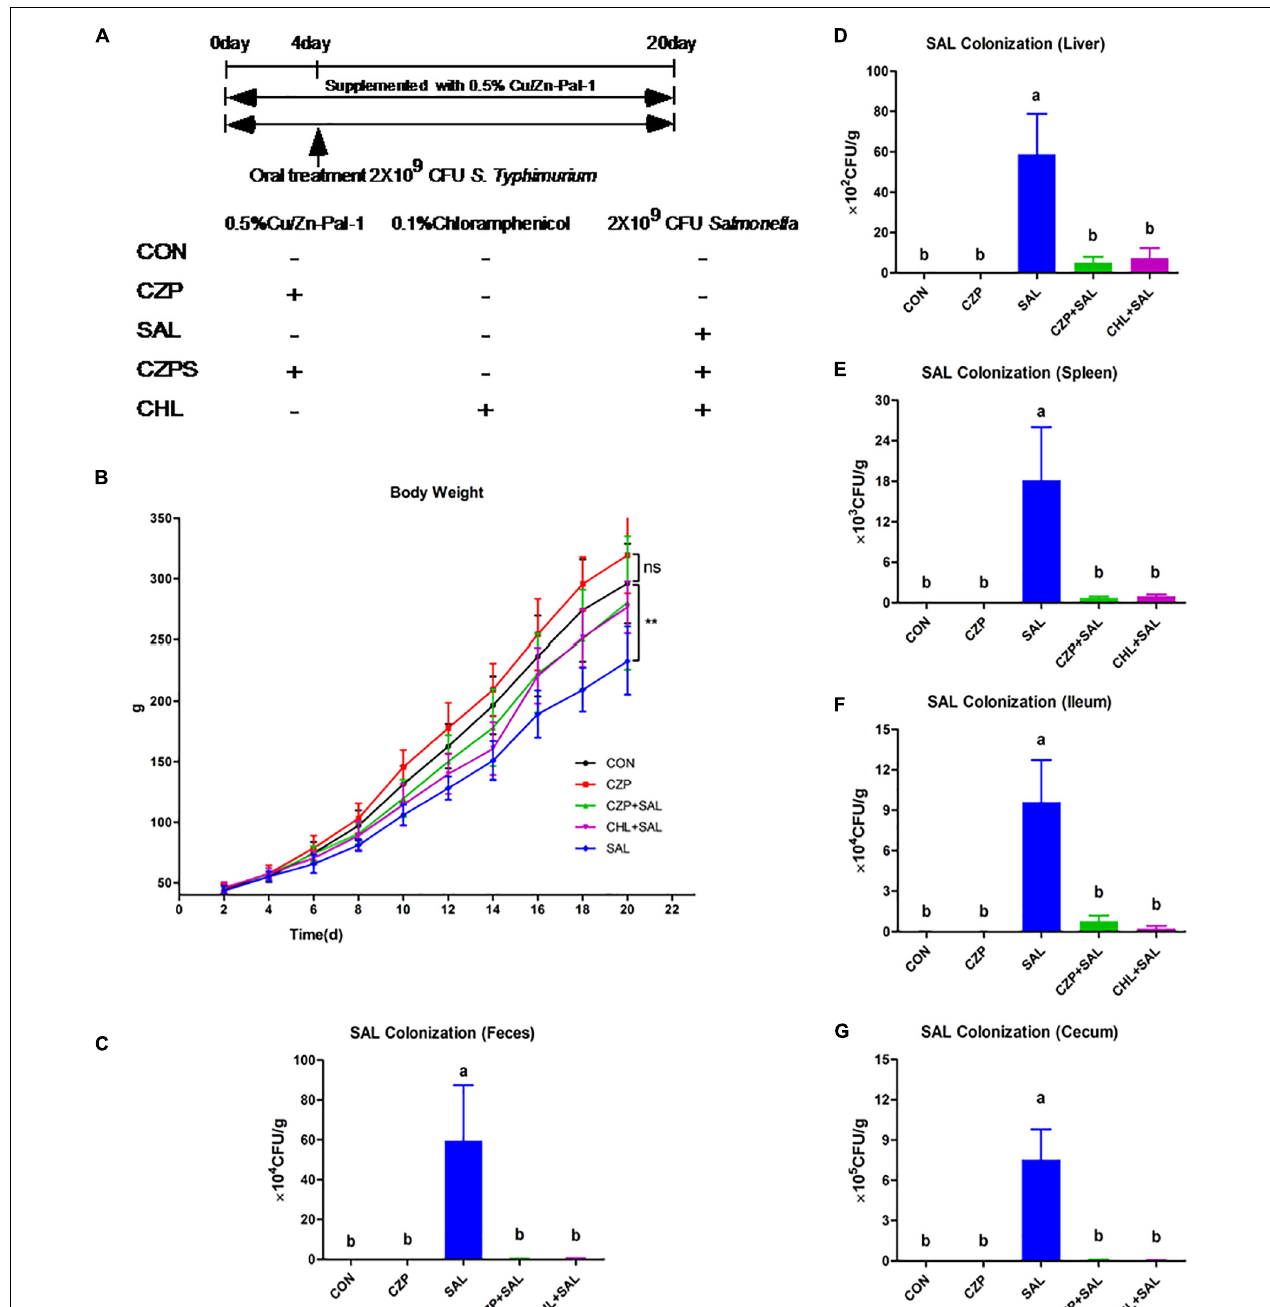
FIGURE 2 | Cu/Zn-Pal-1 enhances weight gain and significantly reduces the S. Typhimurium load in the feces and tissues of infected chicks. (A) Schematic diagram of the animal experiment. (B) The changes in body weight of the chickens during the experiment ( n = 15/group). Data are expressed as the mean ± SD. Differences in the body weights of each group of chickens at day 20 were analyzed by one-way ANOVA. ** p < 0.01. ns, no significant difference. (C–G) The load of S. Typhimurium in feces, the liver, spleen, ceca, and ileum ( n = 9/group). Data are expressed as the mean ± SD. Significant differences were detected using one-way ANOVA statistical analysis ( p < 0.05). Different letters indicate that changes between groups are statistically significant.